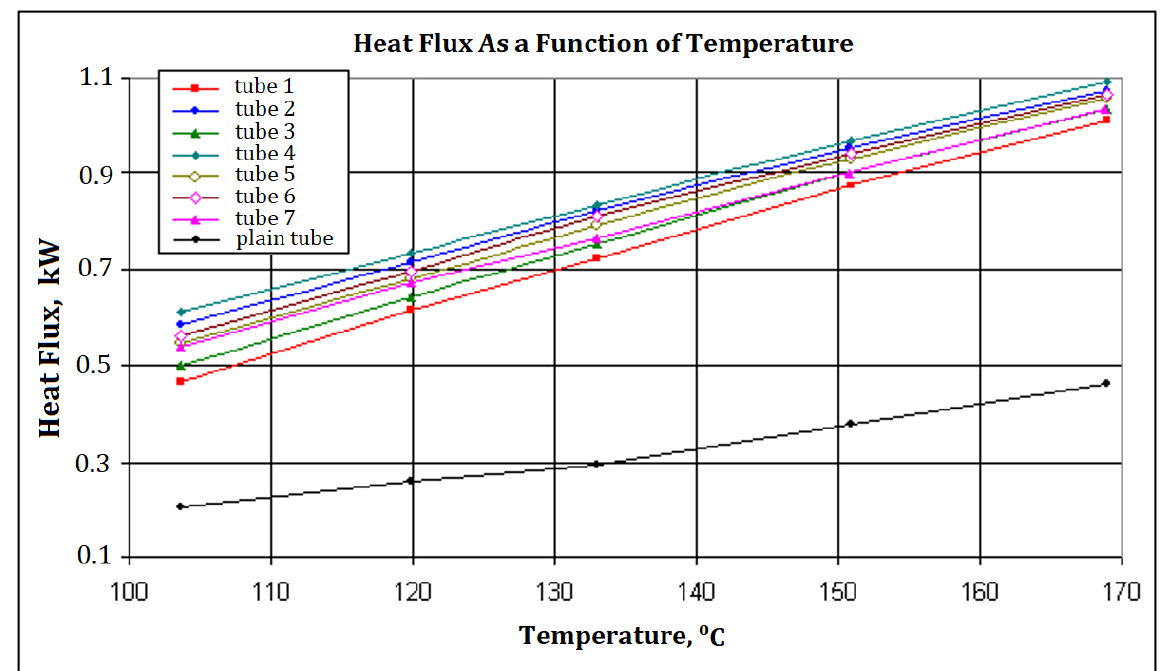
Figure 5. The measured heat fluxes transferred by the tested tubes from steam to air.